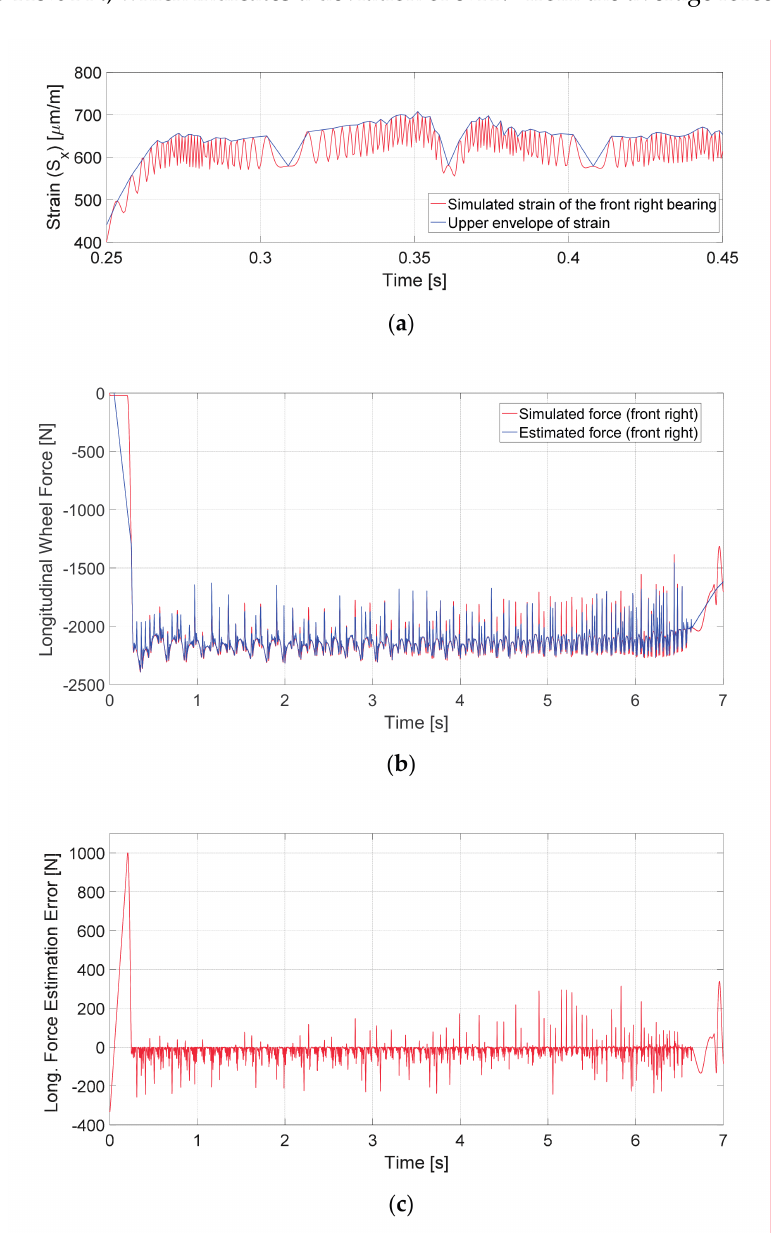
Figure 8. Assessment of the force estimation accuracy by solving the inverse problem: ( a ) strain simulated for the front right hub bearing (red line) and its upper envelope (blue line) shown for a short time interval; ( b ) longitudinal wheel force obtained from the simulation (red line) and estimated force (blue line) for the whole duration of the maneuver; ( c ) force estimation